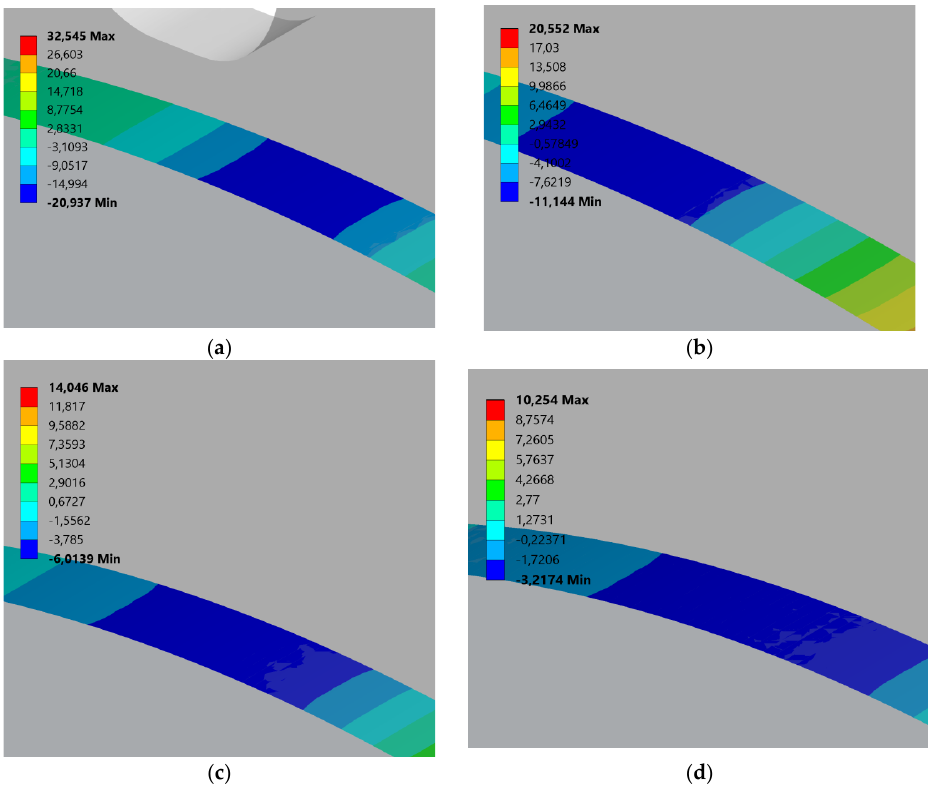
Figure 13. Normal stress results for hybrid gears generated rack tip radius, ρ 1 = 0.3 xm for different RTs; ( a ) 0.5 xm, ( b ) 1 xm, ( c ) 1.5 xm, ( d ) 2 xm. Machines 2022 , 10 , x FOR PEER REVIEW